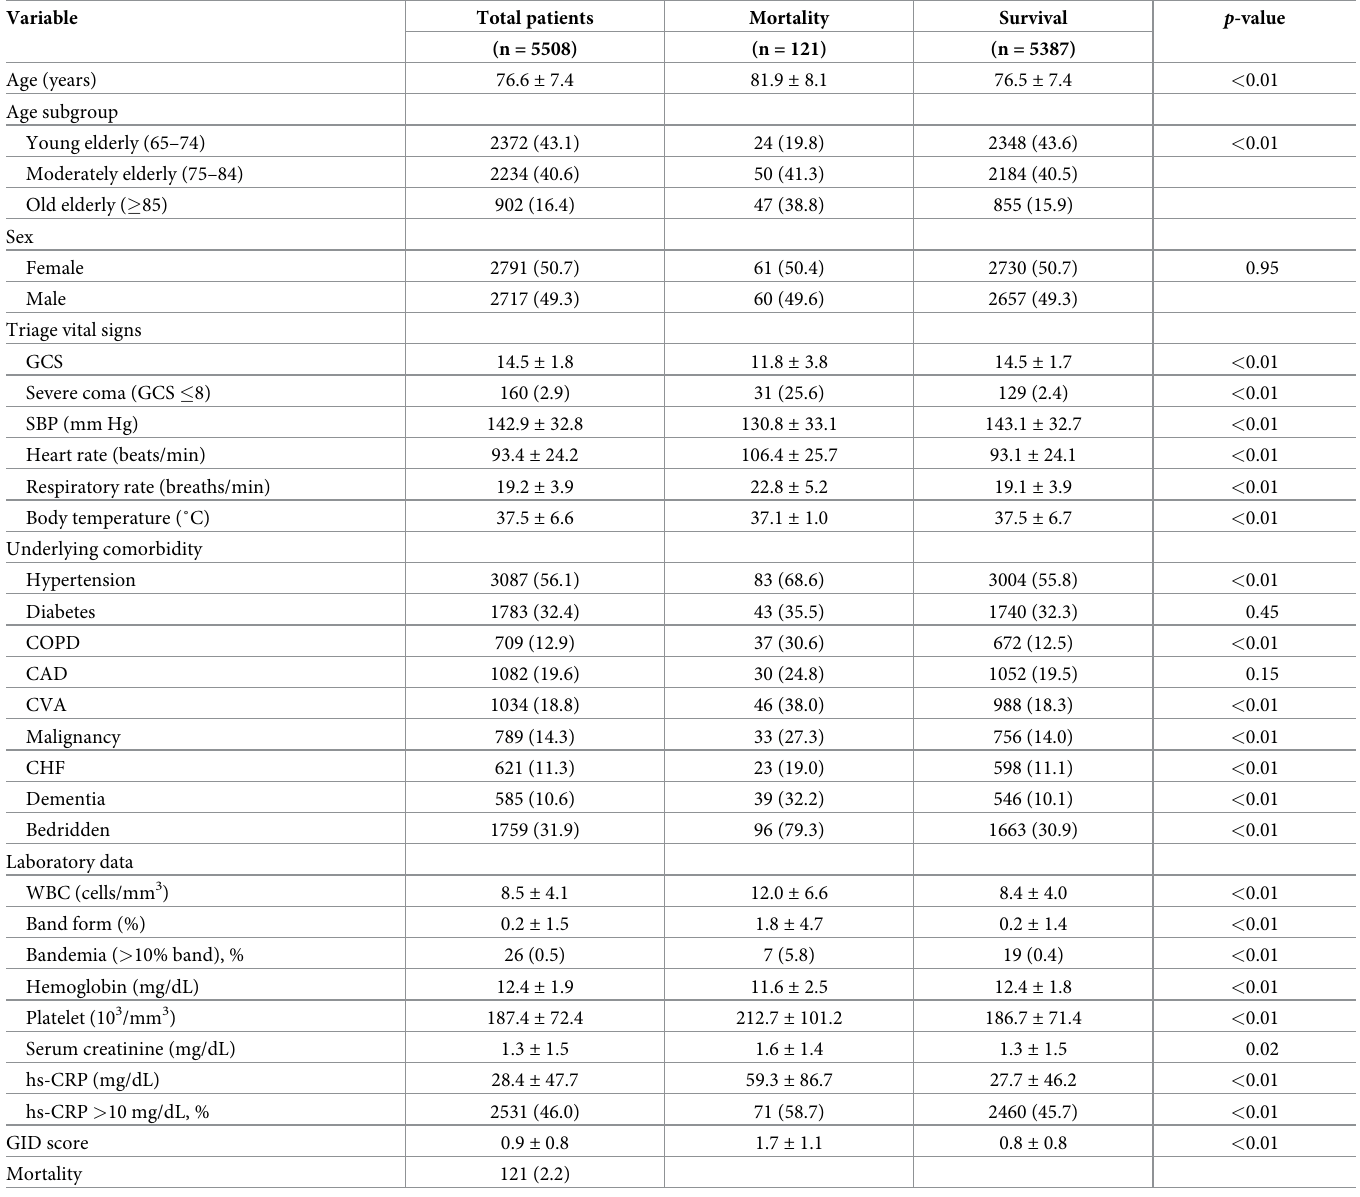
Table 1. Characteristics of all older patients with influenza between 2009 and 2018 in